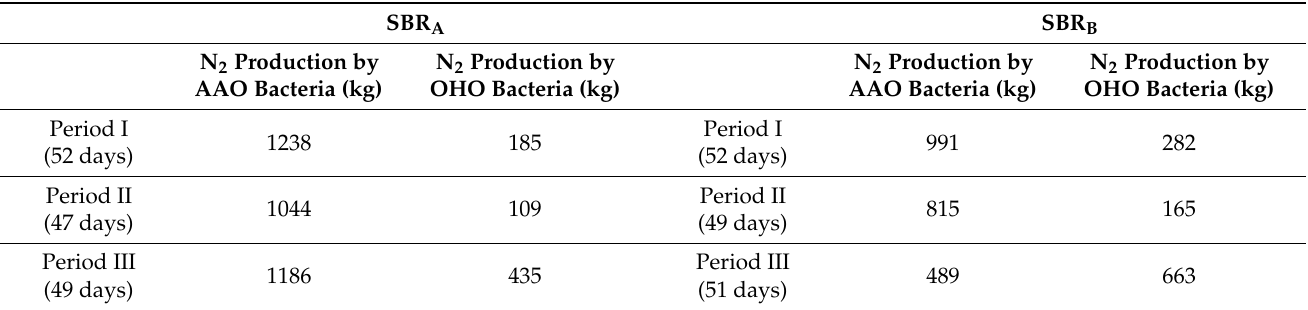
Table 7. Nitrogen removal predicted as N 2 production in SBR A and in SBR B . SBR A SBR